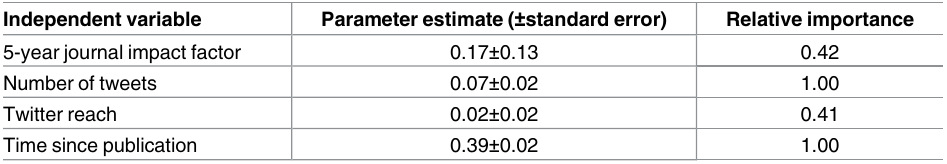
Table 3. Standardized effect sizes ( ± standard error) of variables affecting the number of Web of Sci- ence citations receivedby 1,599 primary research articles published in ecology journals between 2012 and